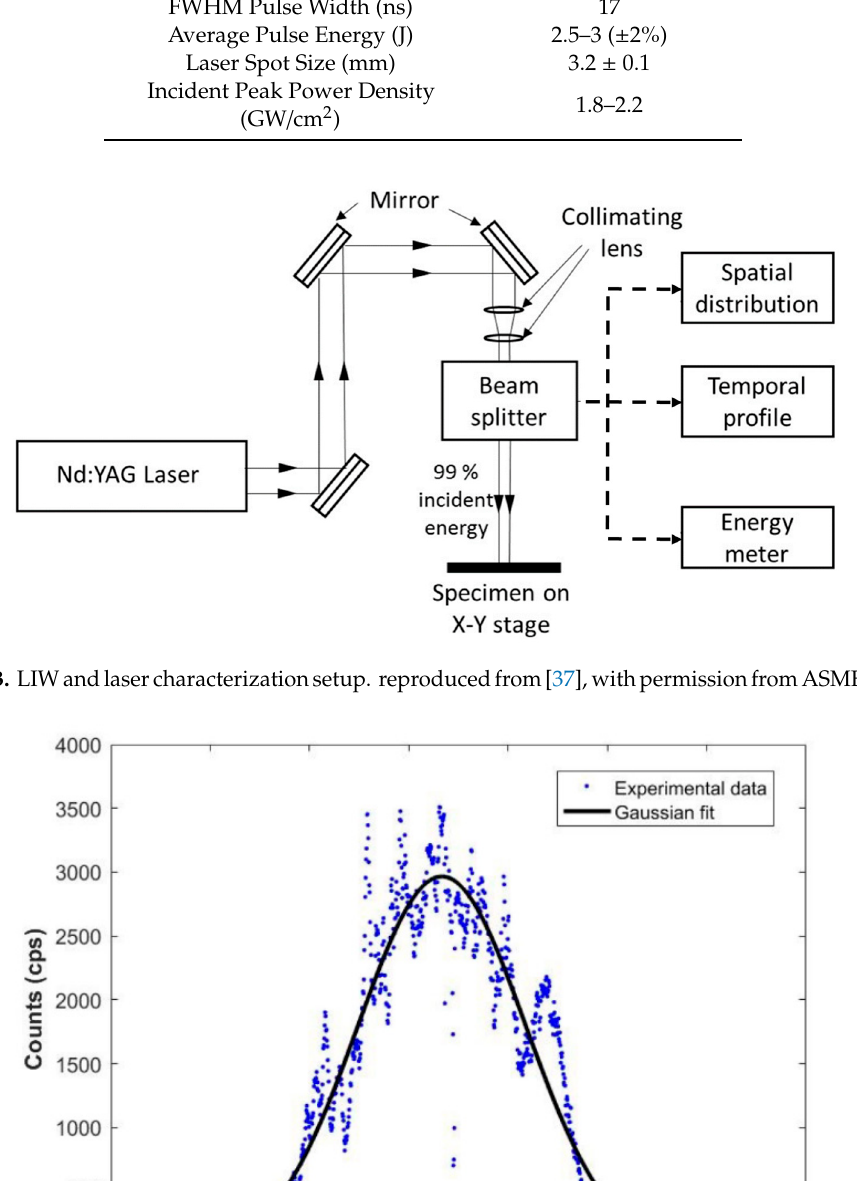
Figure 2. Structure of a LIW specimen: ( a ) Schematic of the LIW specimen (top and side views); ( b ) Schematic of the LIW specimen (isometric view); ( c ) An actual LIW specimen after laser impact.